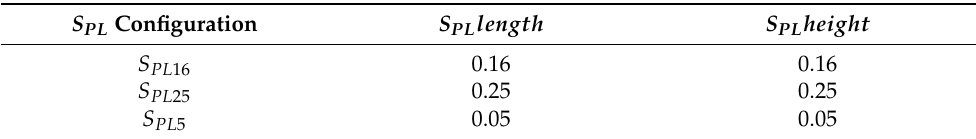
Table 4. Pillar size ( S PL ) configurations used in fine-tuning.